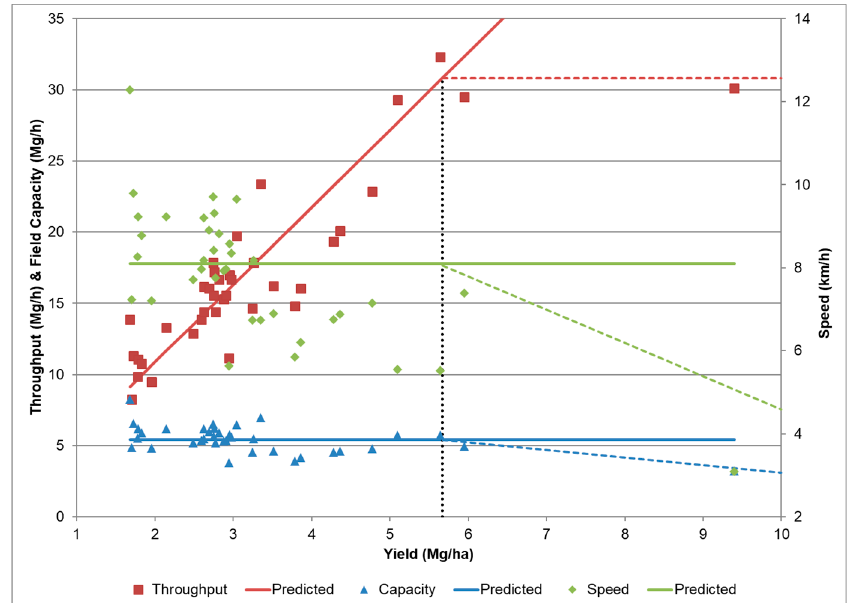
Figure 5. Throughput reached a maximum capacity. The relationship of the performance data to yield from Field 2 is shown here. Productivity data does not include time spent wrapping and ejecting the bale. The individual points are observations from field data. The solid and dash lines (green—effective speed, red—throughput, blue—achieved field capacity) are predicted [4] assuming v e = 11.0 km/h, E f = 0.74, and W s = 6.7 m.